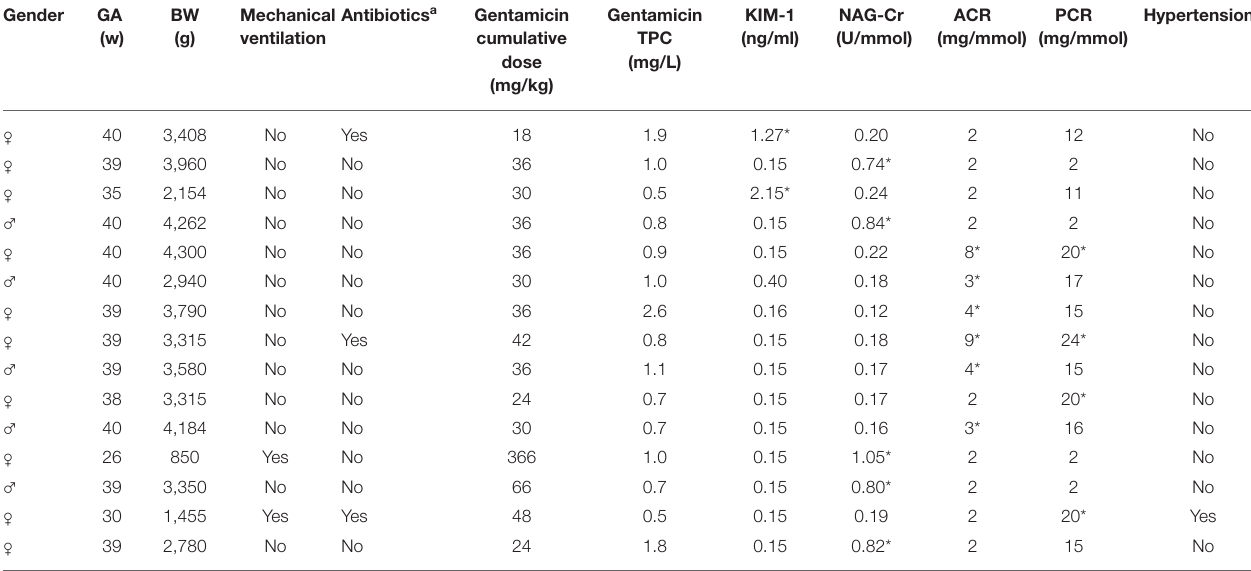
TABLE 3 | Characteristics of the 15 children with one ( n = 13) or two ( n = 2) abnormal urine biomarkers at the follow-up visit. Gender GA BW Mechanical Antibiotics a Gentamicin (w) (g) ventilation cumulative